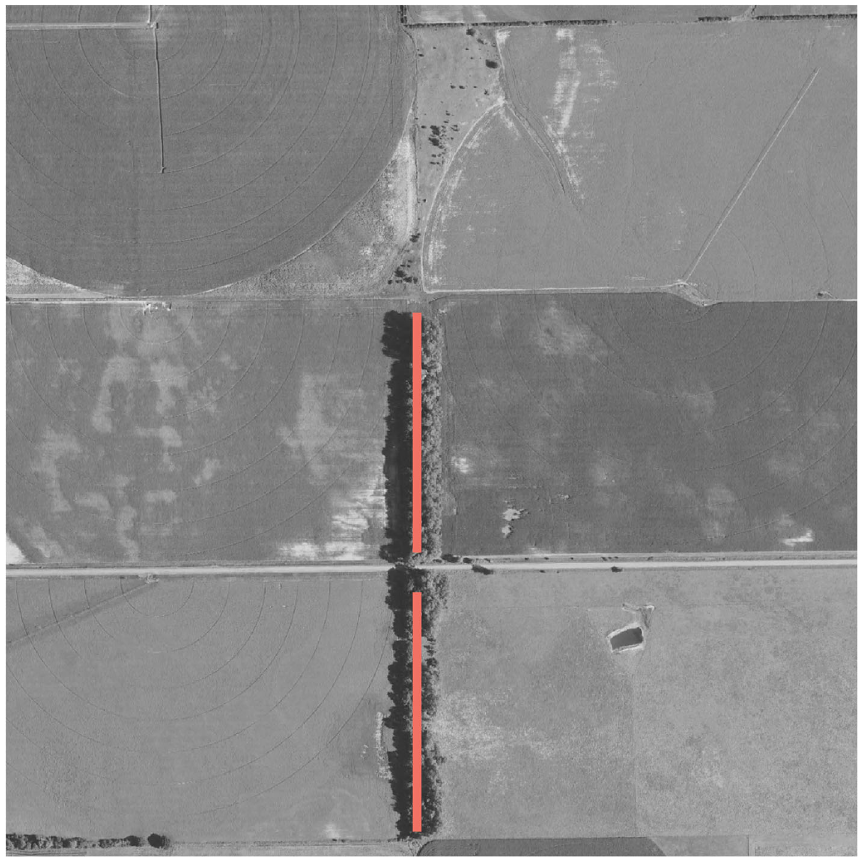
Fig. 6 Overlay Analysis identifying fully intact PSFP shelterbelt (Source: the